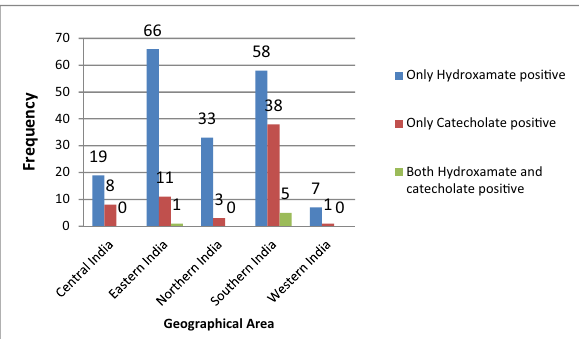
Figure 3: Geographical frequency of siderophore